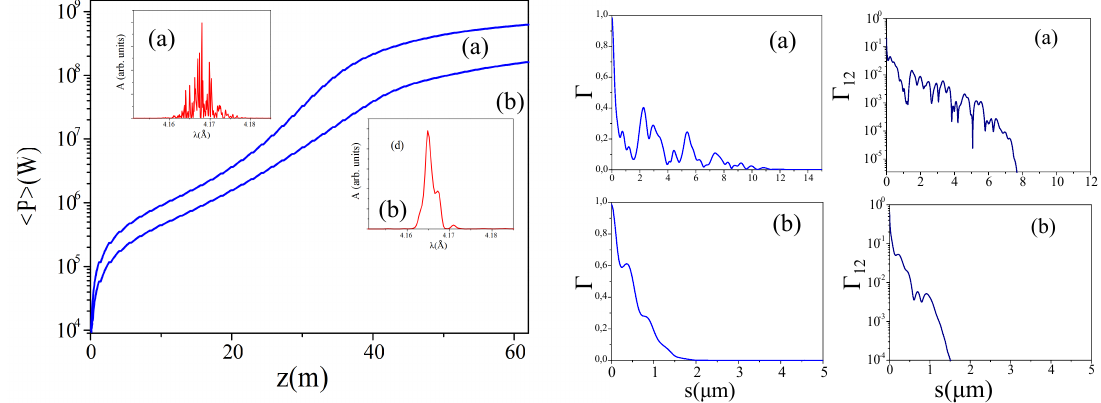
Figure 1. SASE radiation at 4.16 ˚A. Case (a) refers to high charge multispike self amplified spontaneous emission (SASE) regime, case (b) to low charge single spike regime. ( Left panel ): radiation growth vs. undulator coordinate; ( Right panels ): one shot coherence degree Γ and mutual coherence degree between two uncorrelated shots Γ 12 as function of the longitudinal